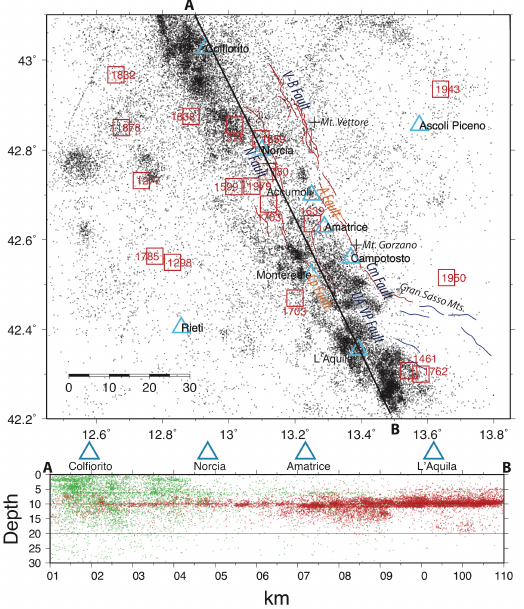
Figure 2. Top: Map showing the distribution of seismicity (1981 - 23th August 2016) in the central Apennines. Squares: historical earthquakes, I>=VIII. Faults: V-B (Mt Vettore-Bove) Fault; N (Norcia) Fault; A (Amatrice) Fault; Cm (Campotosto) Fault; Ua-Pa (Upper Aterno-Pa- ganica) Fault; Cp (Capitignano) Fault). Bottom: Vertical section (thickness 15 km) of seismicity reported on the Top; Green circles for CSI Catalogue, Red circles for Bulletin catalogue (trace in the upper